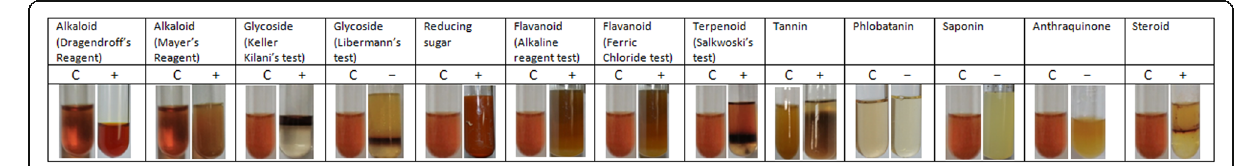
Fig. 1 Phytochemical analysis of C. compressus root. C, control; +, presence; – , absence